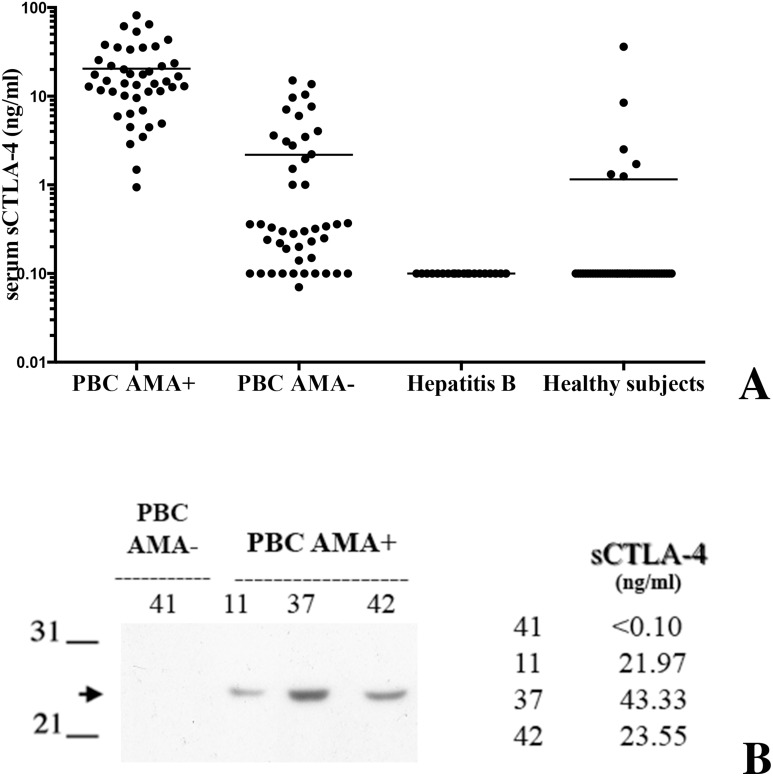
A sCTLA-4 is found in serum of PBC AMA-positive patients.Panel A, The concentration of sCTLA-4 was evaluated by ELISA on sera collected from AMA-positive PBC patients, AMA-negative PBC patients, and hepatitis B-infected patients and healthy donors as controls. Results are expressed as nanogram per milliliter. Each sample was diluted 1∶10 and tested in triplicate. Samples showing values higher then the detection limit of the test (50 ng/ml) were diluted appropriately and tested again. Deviation between triplicates was <10% for any reported value. Panel B, Immunoprecipitation of sCTLA-4 was performed on sera from a representative group of AMA-positive PBC patients. In addition, a serum undetectable sCTLA-4 dosing (below the sensibility of the text) was shown. Arrow marks 23 kDa species.